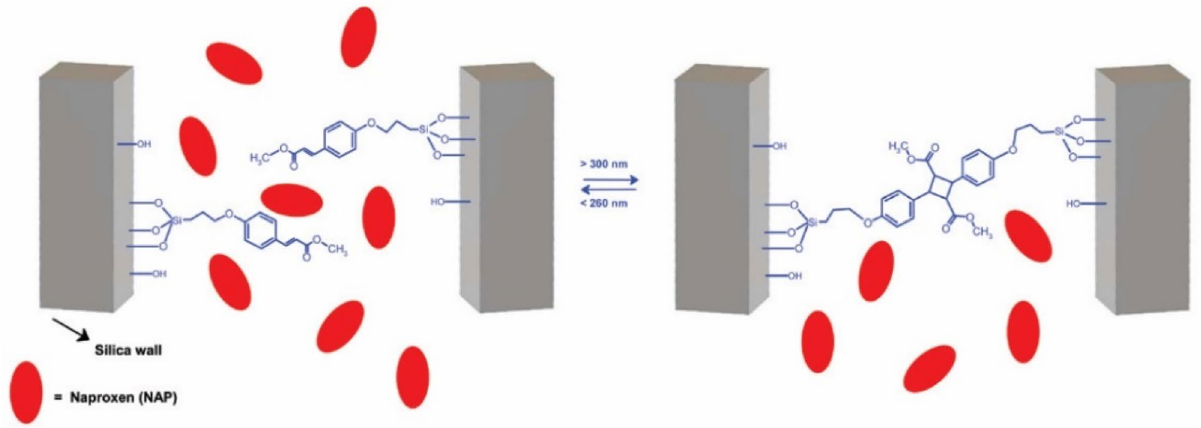
Figure 1. Mechanism of pore closing / pore opening using irradiation with UV